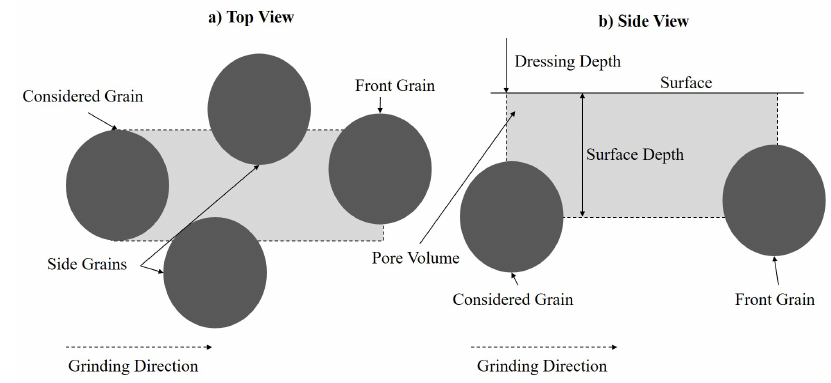
Figure 13. Visualisation of effective pore volume; partly adapted from [16].